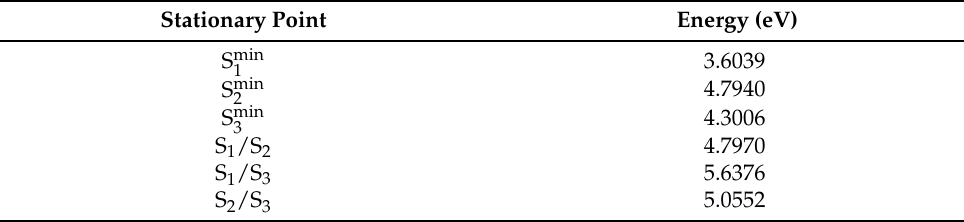
Table 2. Relevant stationary points (state minima and MECI) on the coupled S 1 –S 2 –S 3 PESs of C 7 H 4 .